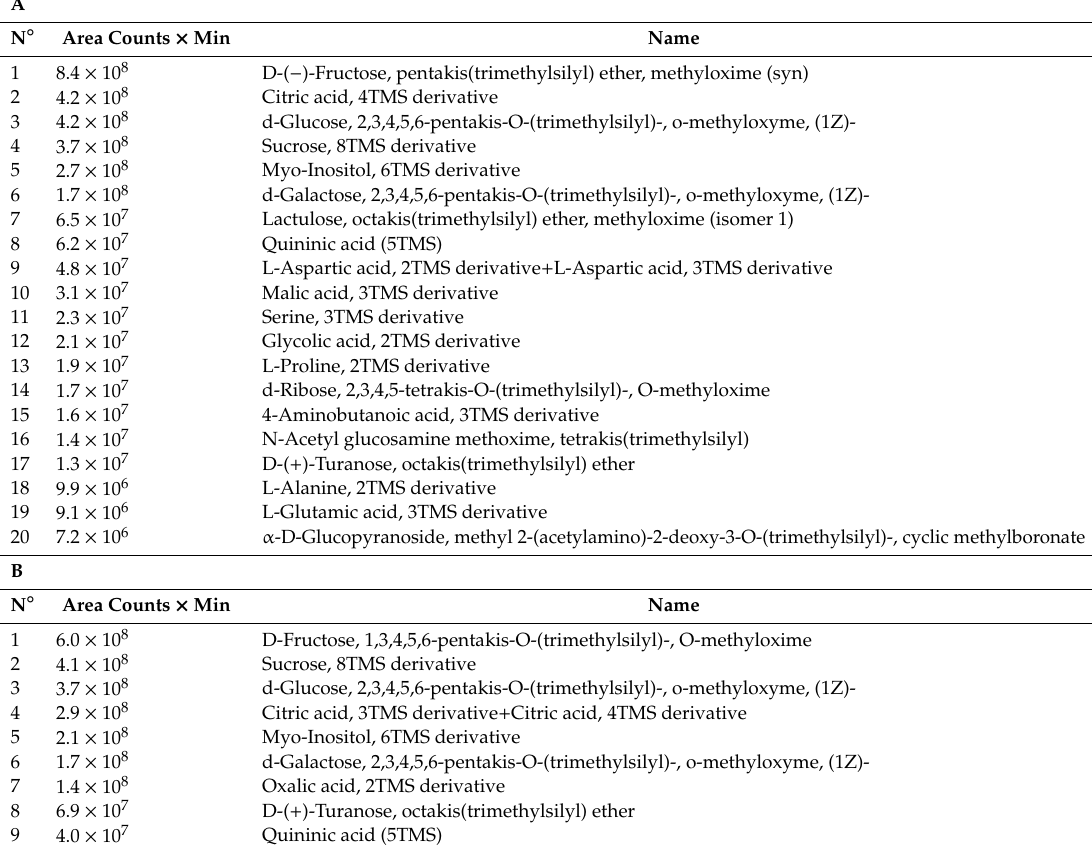
Table 1. Top ranking metabolites tentatively-identified in grapefruit ( A ) fruit juice, ( B ) MVs and ( C ) NVs. A N ◦ Area Counts × Min